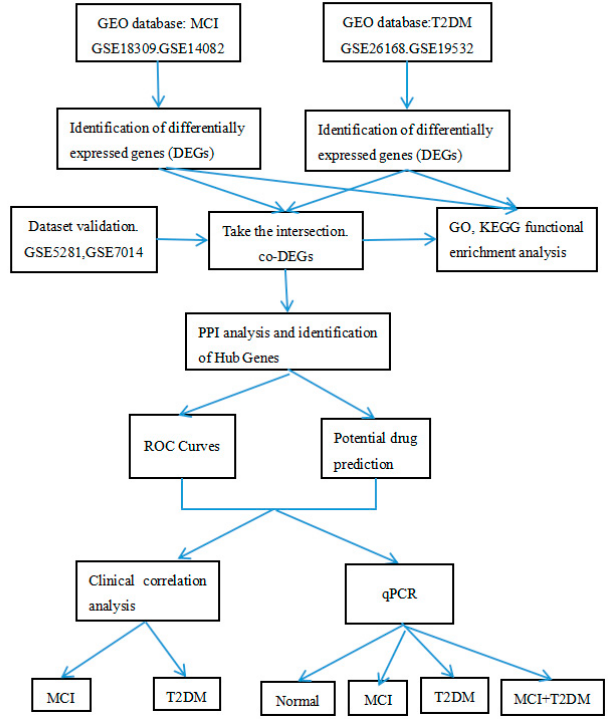
Figure 1. Flowchart for exploring blood co-expressed genes in T2DM and MCI.